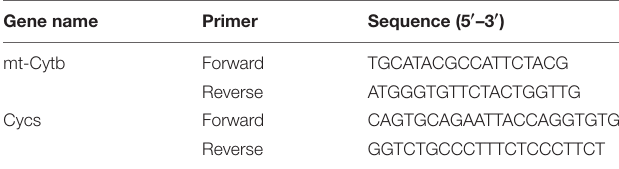
TABLE 3 | Primer sequences used for mtDNA analysis of